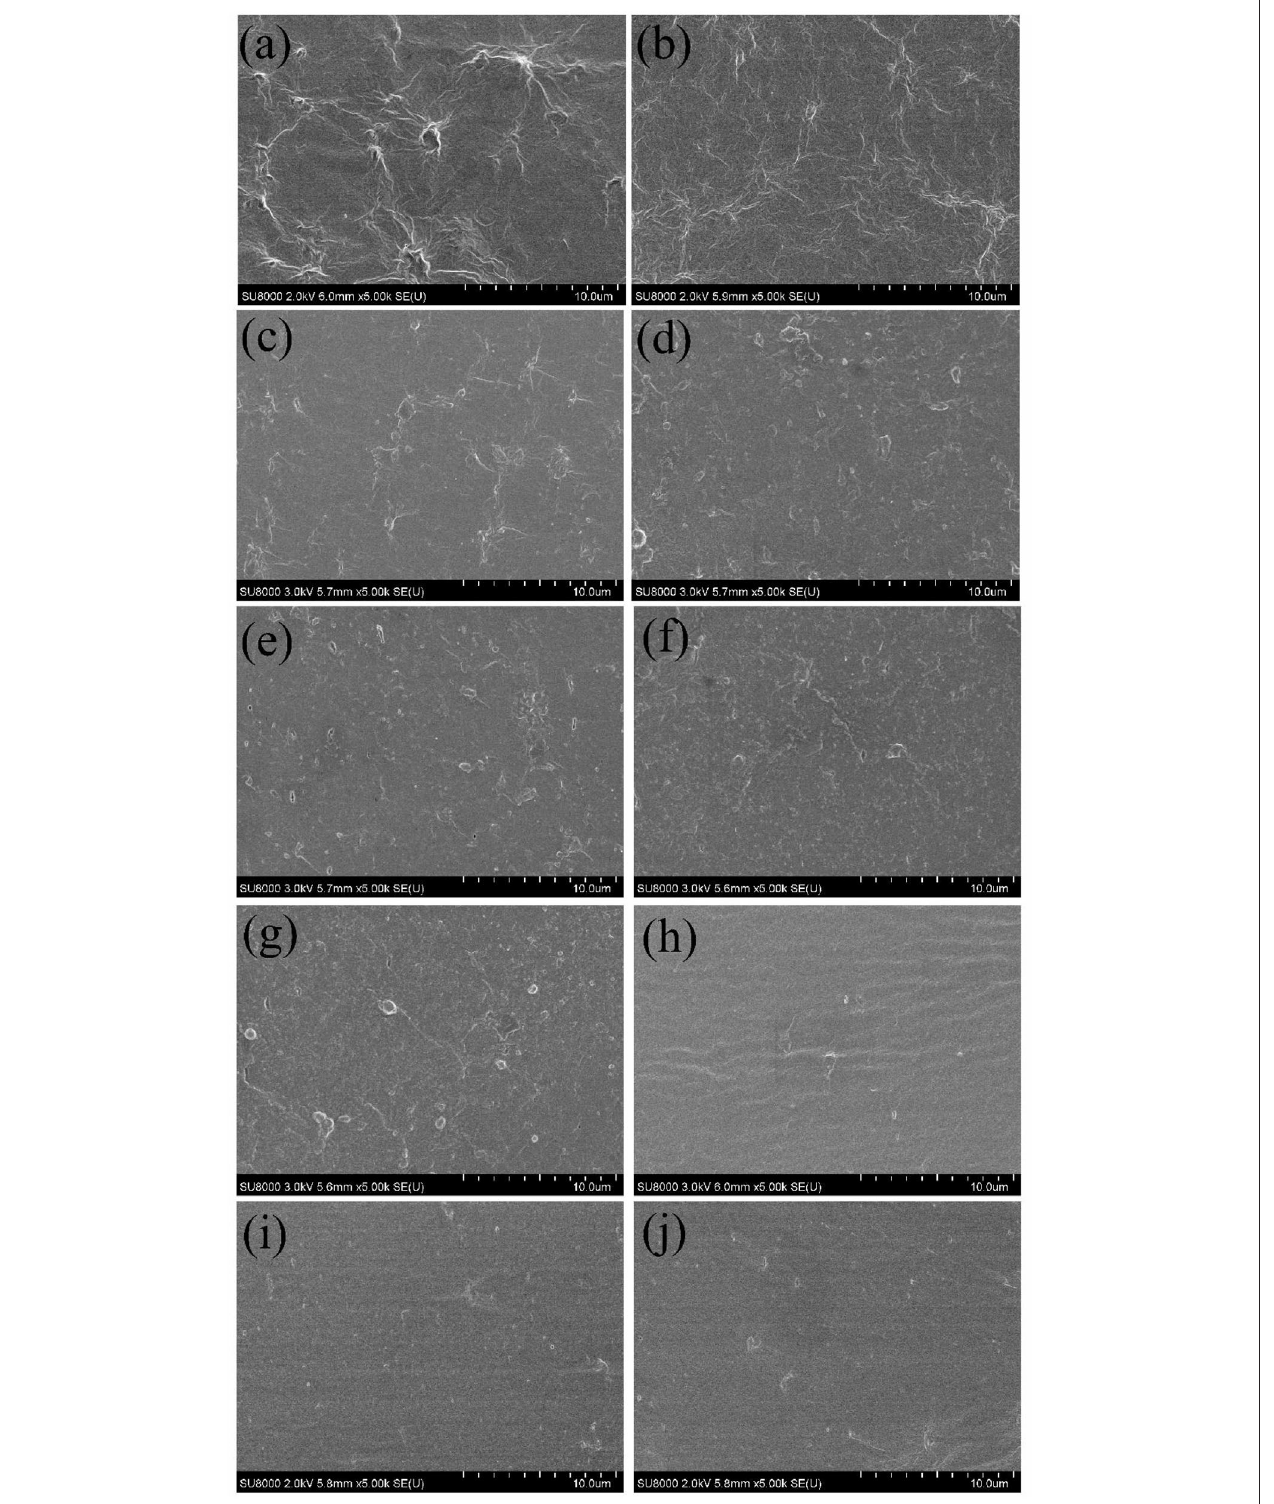
FIGURE 2 | Cross-section scanning electron microscope (SEM) images for grasshopper protein (GP)-based composite films. (a) control, (b) 8–2, (c) 7–3, (d) 6–4, (e) XY5, (f) XY10, (g) XY15, (h) CIN10, (i) CIN20, and (j) CIN30.